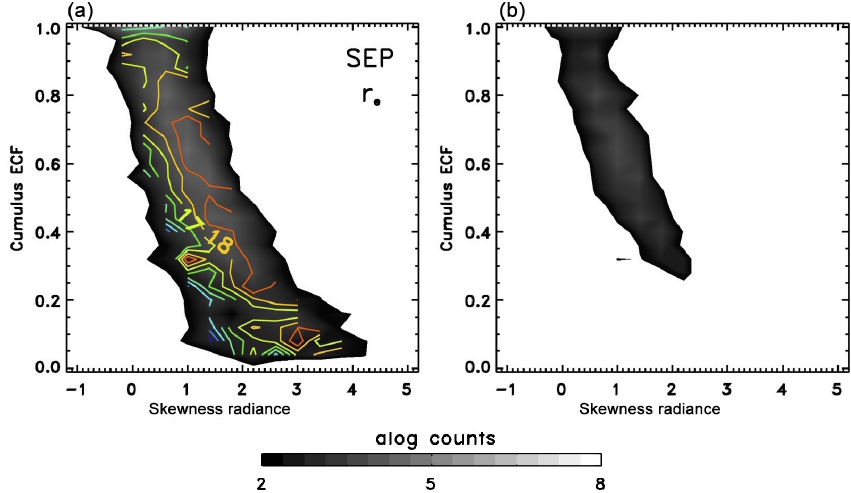
Figure 11. (a) Same as Fig. 10n except that sampling is restricted to AMSU FORs that contain the CloudSat ground track. (b) Samples of the data in (a) that contain detected precipitation according to